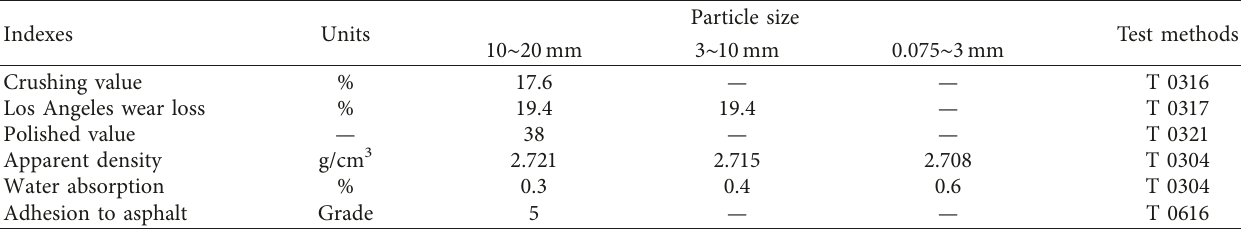
Table 2: Physical properties of the RAP aggregate.